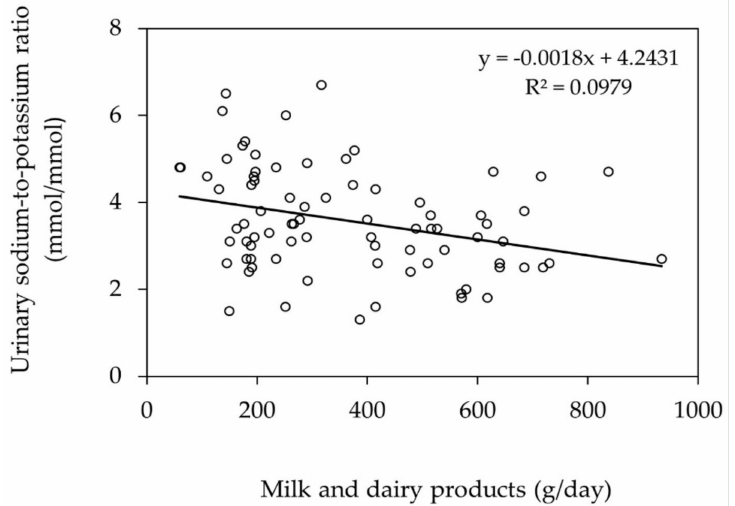
Figure 2. Association between milk and dairy products and the urinary sodium-to-potassium ratio. As a characteristic eating habit, Japanese have a high intake of vegetables and seafood, but their salt intake is also high. Salt content is high in traditional Japanese foods, such as soy sauce, miso soup, and Japanese pickles. On the other hand, the consumption of milk and dairy products is very low when compared to that in Western countries. Therefore, the amount of calcium in Japanese cuisine does not meet the recommended amount by the Japanese DRIs [12]. One of the problems of adolescents in Japan is the inadequate intake of nutrients caused by shortened sleep hours and skipping breakfasts. Japanese dietary guidelines strongly recommend the daily consumption of breakfast